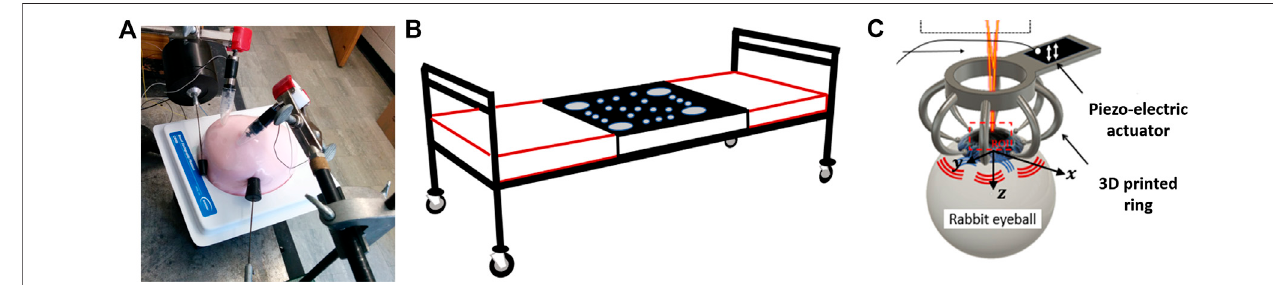
Frontiers in Physics |